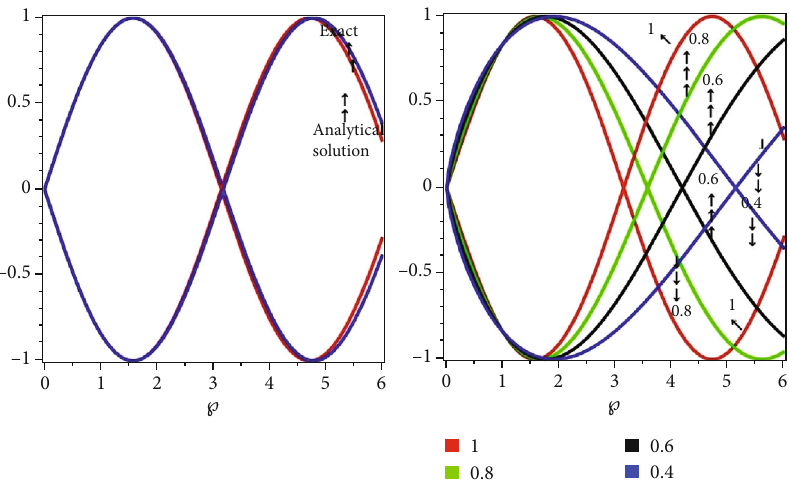
Figure 3: The fi rst graph depicts a two-dimensional fuzzy upper and bottom branch graph of an analytic series result, while the second depicts various fractional of ρ